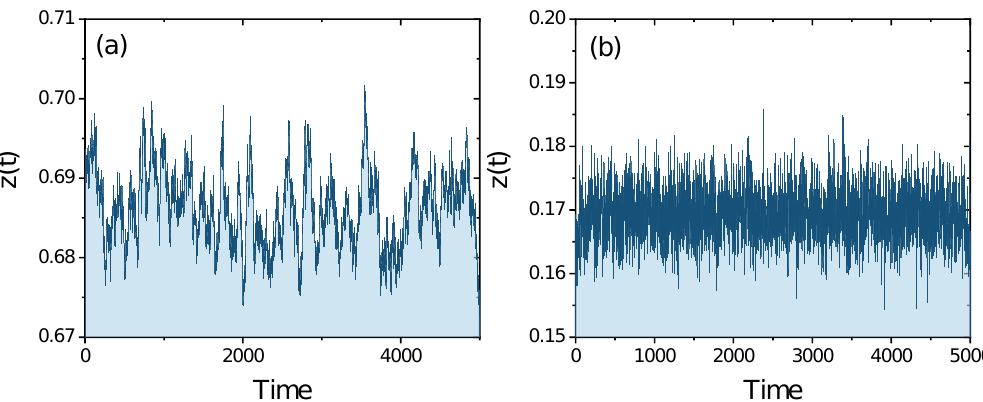
Figure 2. Model dynamical recovery on the RR network for < k > = 10, m = 4, p ∗ = 0.3, r = 0.78 with N = 10 5 . ( a ) The high activity steady state ( z ( t ) is about 0.685) for the increasing direction of p ∗ (from 0 to 1). ( b ) The low activity steady state ( z ( t ) is about 0.17) for the decreasing direction of p ∗ (from 1 to